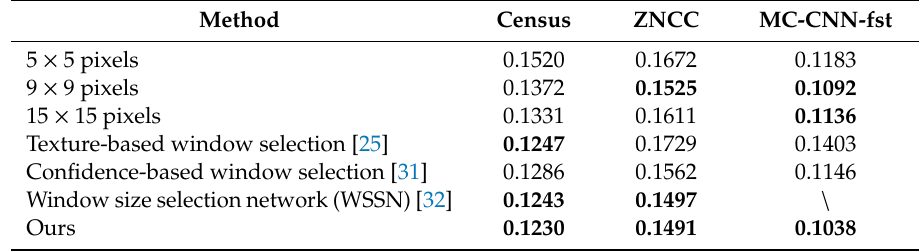
Table 1. Mismatch-3 comparison of seven di ff erent methods on the Middlebury dataset (bold records indicate the top-three optimal results among each of the considered matching cost